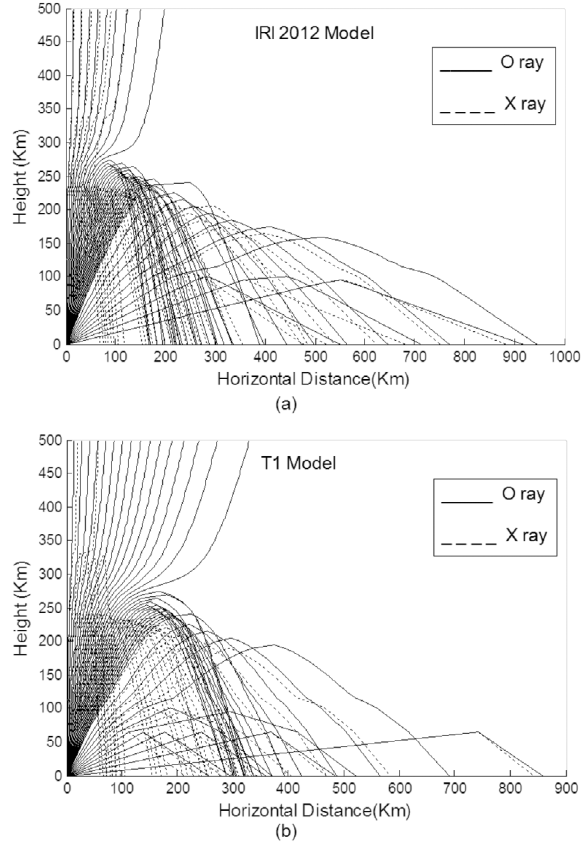
Figure 2. Ray tracing at 7.5 MHz for different angle of incidence under Case 1 and without Earth’s magnetic field when the back- ground is, (a) IRI 2012 model of the ionosphere and (b) T1 model of the ionosphere.